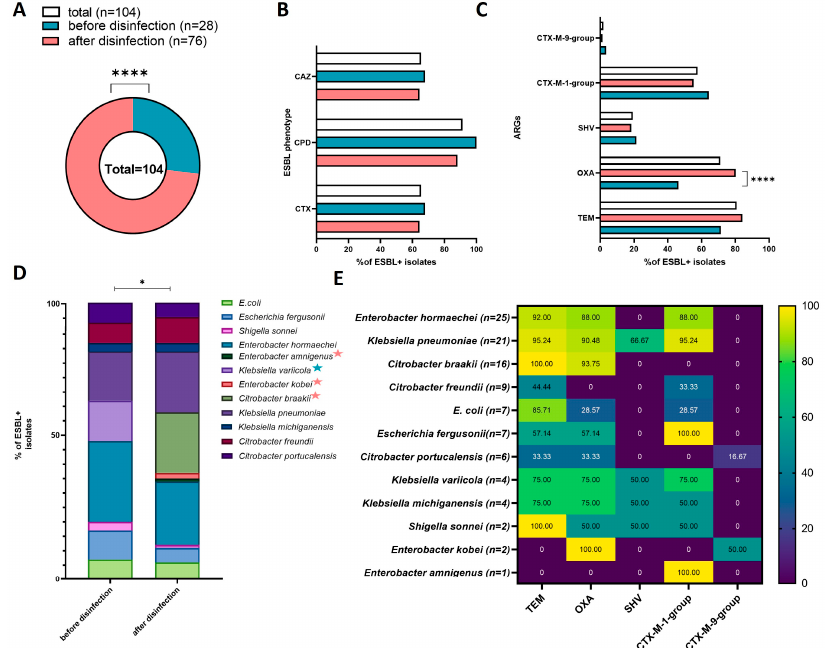
Figure 4. Prevalence and characteristics of ESBL+ isolates in each sampling site and in all sites: ( A ) pie chart presenting the number of ESBL+ isolates; ( B ) bar chart presenting the percentage of ESBL+ isolates with the phenotypic ability to produce ESBL against the tested antibiotics in the Combined Disc Test (cefpodoxime (CPD), ceftazidime (CAZ), cefotaxime (CTX)); ( C ) percentage of ARGs in ESBL+ isolates; ( D ) percentage of bacterial species in ESBL+ isolates from sampling sites (species identified in only one site are marked with a colored star; star colors are explained in the legend of chart A); ( E ) heatmap presenting the percentage of ARGs in the total number of ESBL+ isolates. Black stars denote significant differences at * p < 0.05, **** p < 0.0001. Table 1. Co-occurrence of ARG profiles in ESBL+ bacterial isolates.